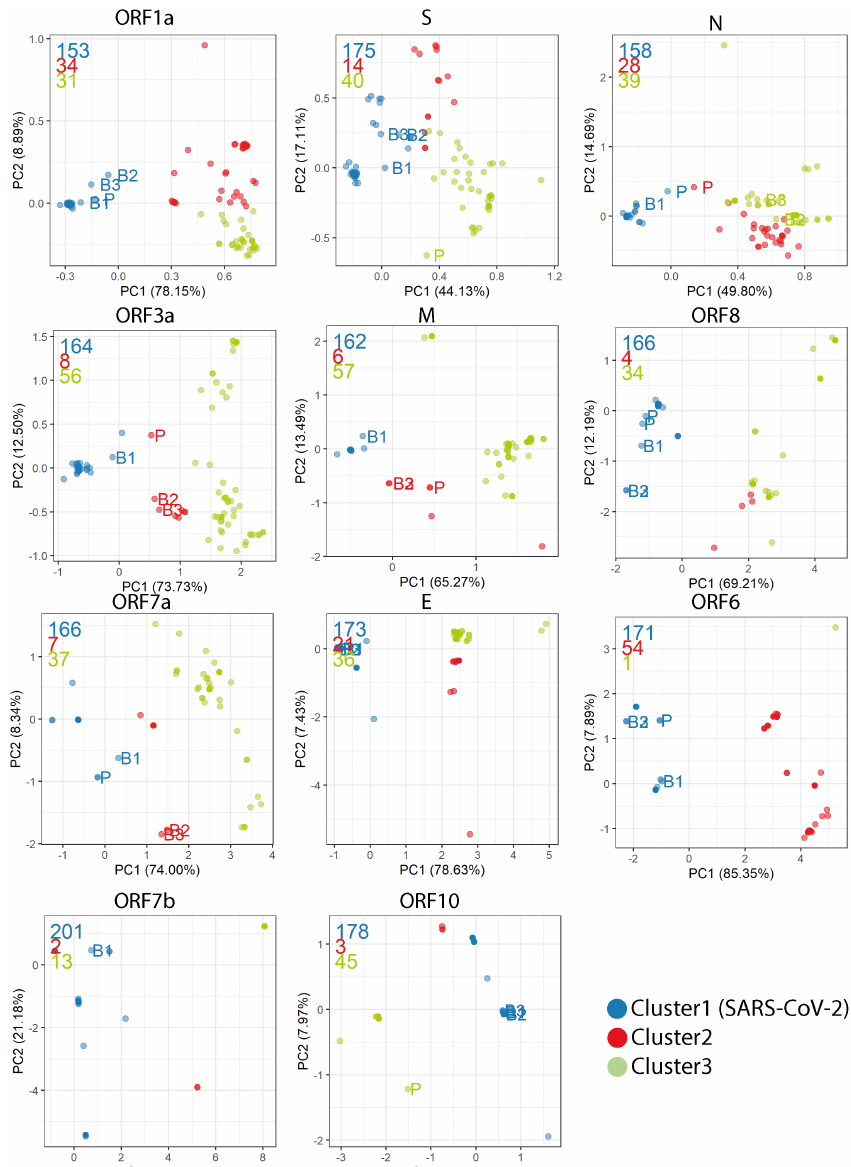
Figure A7. Relative synonymous codon usage (RSCU) was calculated as the ratio of the observed frequency of codon to the expected frequency under the assumption of equal usage between synony- mous codons for the same amino acids. For each gene, Principal Component Analysis (PCA) was carried out on the RSCU values, and the first 10 Principal Components (PCs) were used to group the genomes into 3 clusters through kmeans clustering. The cluster with the most number of SARS-CoV-2 genomes is labelled as Cluster 1. Clusters 2 and 3 are assigned according their PC1 and PC2 distance to Cluster 1, with Cluster 2 being closer. Four isolates are labelled: bat-RaTG13 (B1), bat-SL-CoVZC45 (B2), bat-SL-CoVZXC21 (B3), and pangolin-MP789 (P; MT121216.1 and MT084071.1). These 4 isolates are closer to SARS-CoV-2 than other bat-CoV and pangolin-CoV. The number of genomes in Clusters 1, 2 and 3 are indicated in order on the top left corner of each